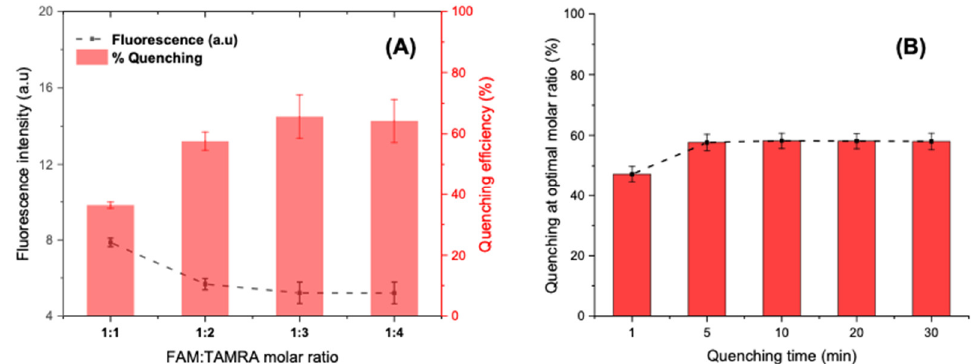
Figure 7. ( A ) Optimization of the FAM-APT-to-TAMRA-cDNA molar ratio for a maximum quenching at a fixed hybridization time of 5 min. ( B ) Optimization of the quenching time at an optimal molar ratio of 1:3.